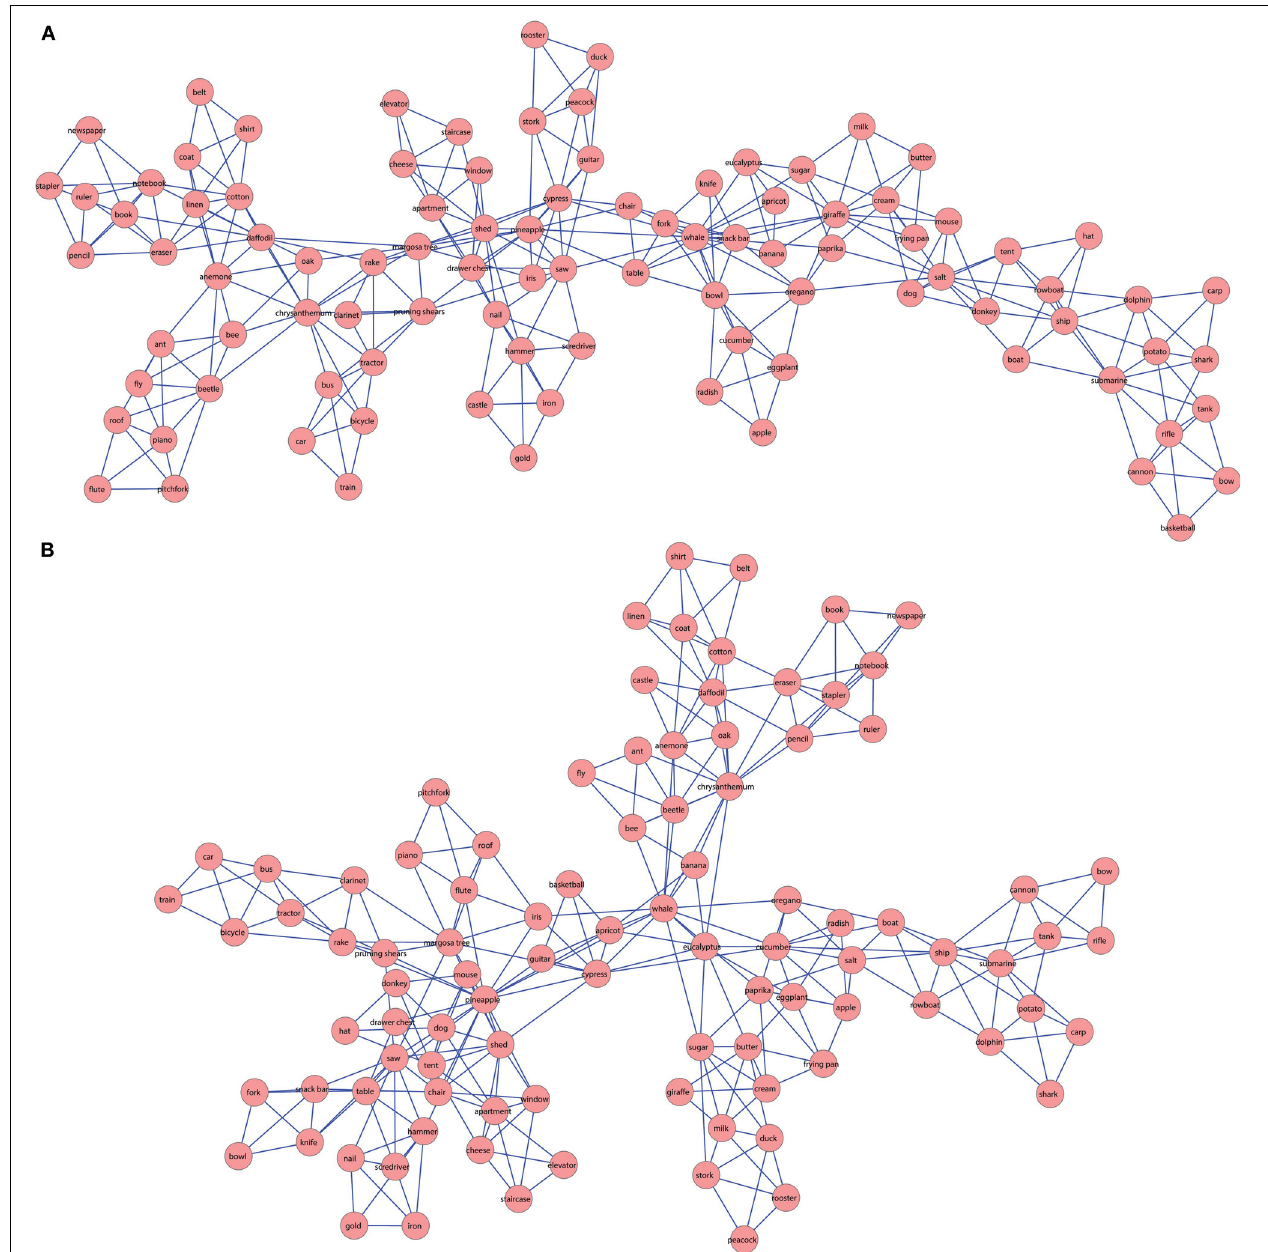
FIGURE 1 | A 2D visualization of the LSC (A) and HSC (B) semantic networks. Nodes are the 96 Hebrew target words translated into English. The links between nodes represents an unweighted, undirected connection between